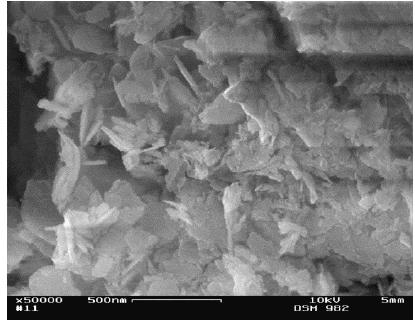
Figure 8. SEM image of M2(0)/SiO 2 90:10 at 50,000× magnification. Catalysts 2020 , 10 , x FOR PEER REVIEW